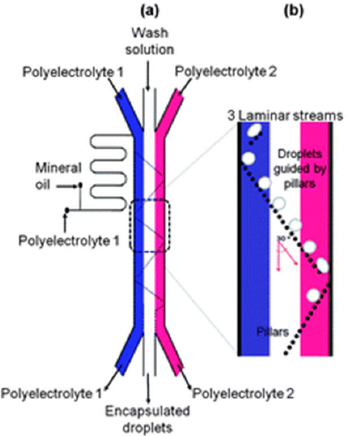
Figure 5. Sketch representing an experimental configuration for the assembly of LbL PEMUCS using a microfluidic device. ( a ) General view representing the inputs and outputs of the assembly process. ( b ) Expanded view of the process of deposition of one bilayer. Reprinted from Kantak et al. [88], Copyright (2011), with permission from The Royal Society of Chemistry.